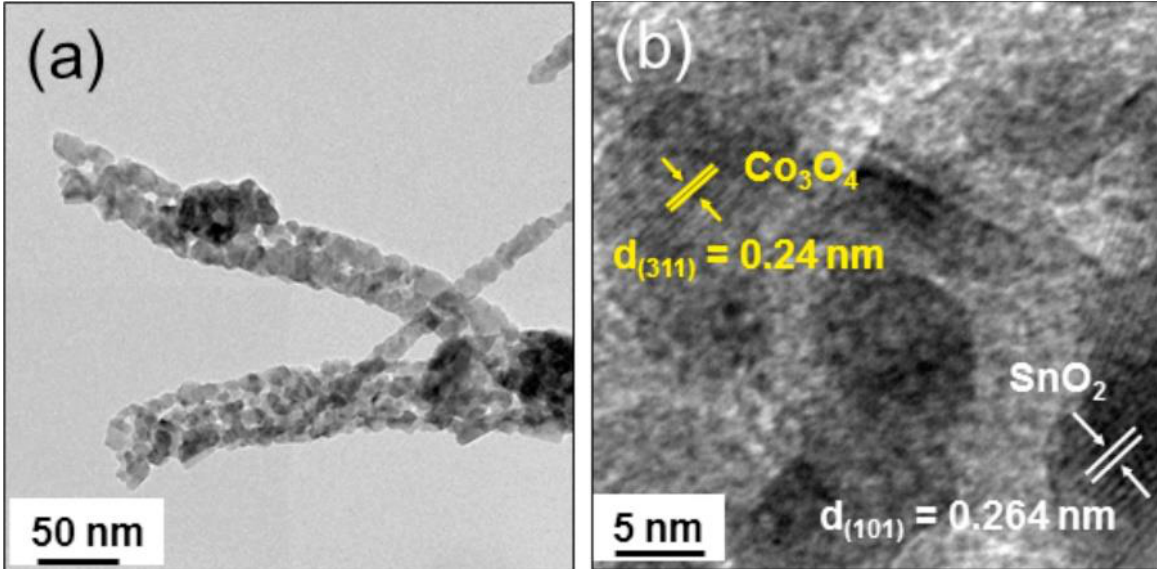
Figure 9. ( a , b ) TEM images of 0.5 SnO 2 –0.5 Co 3 O 4 composite NFs. Reprinted with permission from Ref. [88]. Copyright 2017,